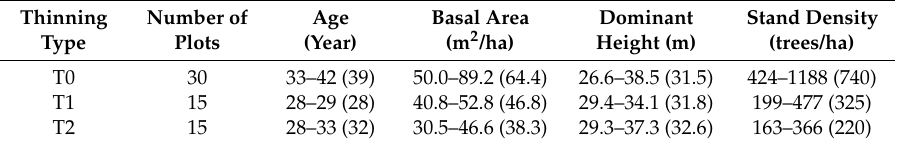
Table 1. Stand attributes of plots in unthinned (T0), once-thinned (T1) and twice-thinned (T2) stands over the 12 sites. The range of each attribute was given together with its average in brackets. Dominant height was calculated as the average height of the 100 largest diameter